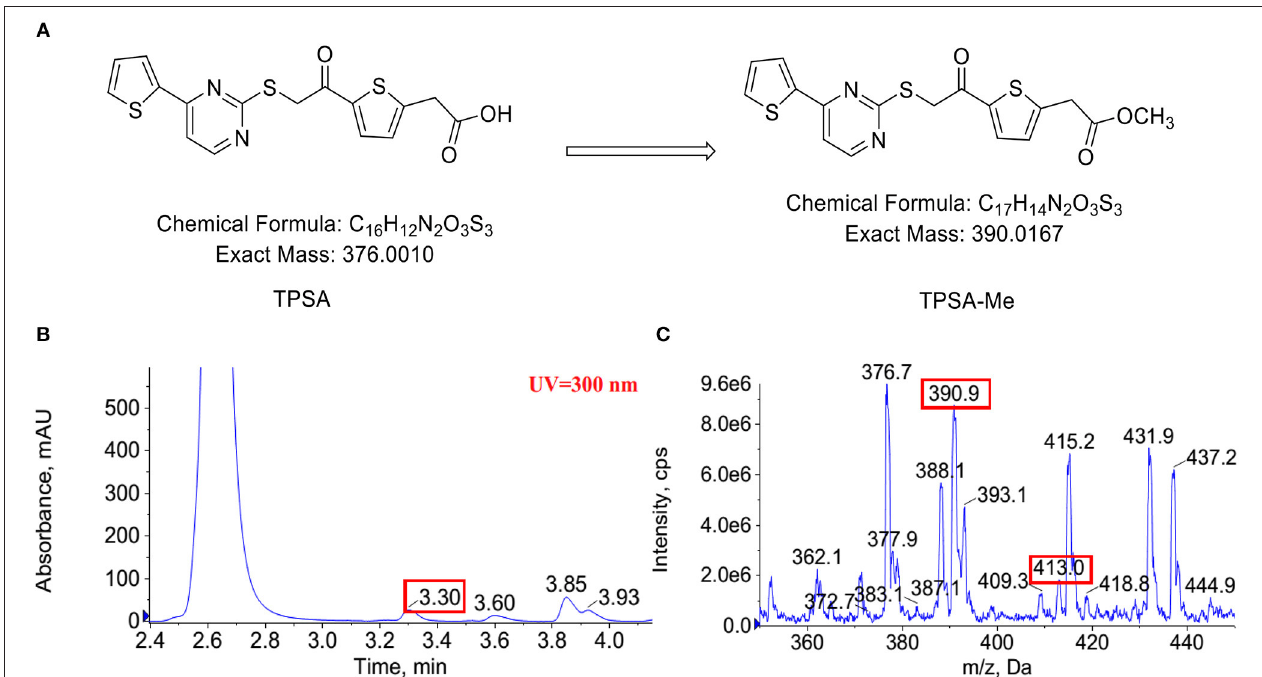
FIGURE 8 | The predicted methylation of TPSA (A) . Methylation of TPSA confirmed by LC-MS after 14h co-incubation of TPSA and Rv0560c in the presence of SAM. The methylated product had a retention time of 3.3min at HPLC-UV (300nm) (B) . The mass spectrum of the methylated product corresponding to 3.3 min: ( + ) ion peak m/z 390.9 [M + H] + and m/z 413.0 [M + Na] + (C)